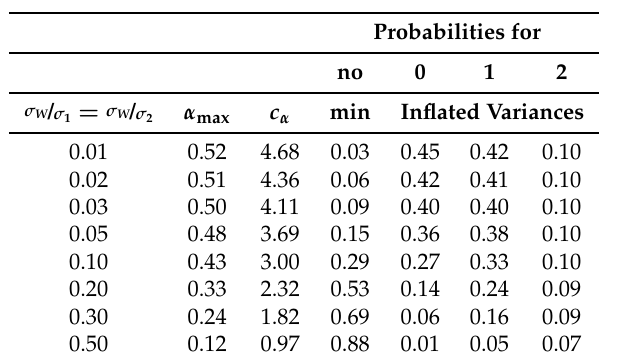
Table 2. Maximum selectable type 1 error probability α max and critical value c α for T VI in (59) for various ratios of σ W / σ 1 = σ W / σ 2 and α = 0.05 as well as probabilities that (16) has no local minimum or that 0 or 1 or 2 variances are inflated.